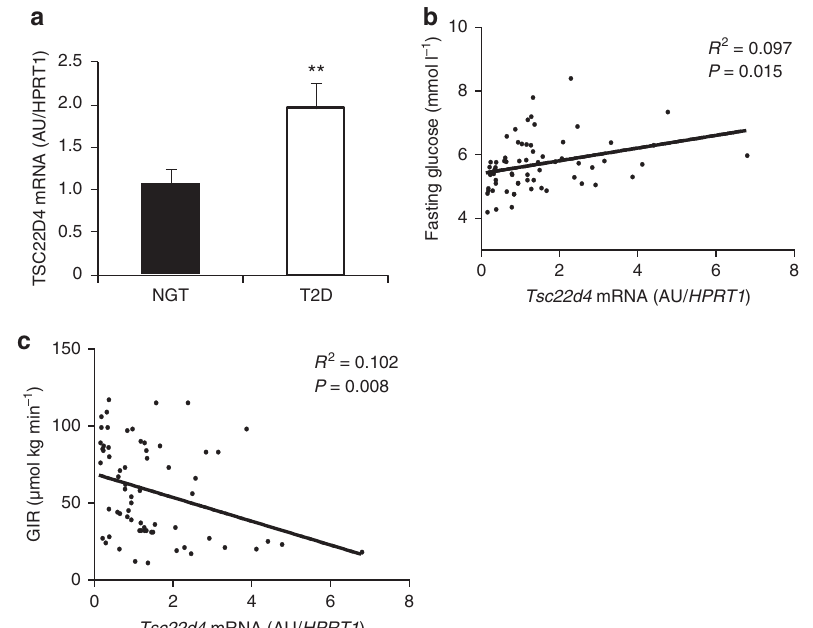
Figure 5 | TSC22D4 levels correlate with insulin sensitivity in humans. ( a ) Quantitative PCR analysis of Tsc22d4 mRNA expression in livers of patients with type 2 diabetes (T2D, n ¼ 26) or normal glucose tolerance (NGT, n ¼ 40) Error bars indicate standard error of the mean (s.e.m.). ( b ) Correlation of hepatic expression of Tsc22d4 mRNA and fasting plasma glucose in the same patients as in a . ( c ) Correlation of human liver expression of Tsc22d4 mRNA and glucose infusion rate (GIR) during hyperinsulemic-euglycaemic clamp study in the same patients as in a . Statistical analysis for a : Student’s t -test, b and c : Pearson correlation coefficient, * P r 0.05; ** P r 0.01; *** P r